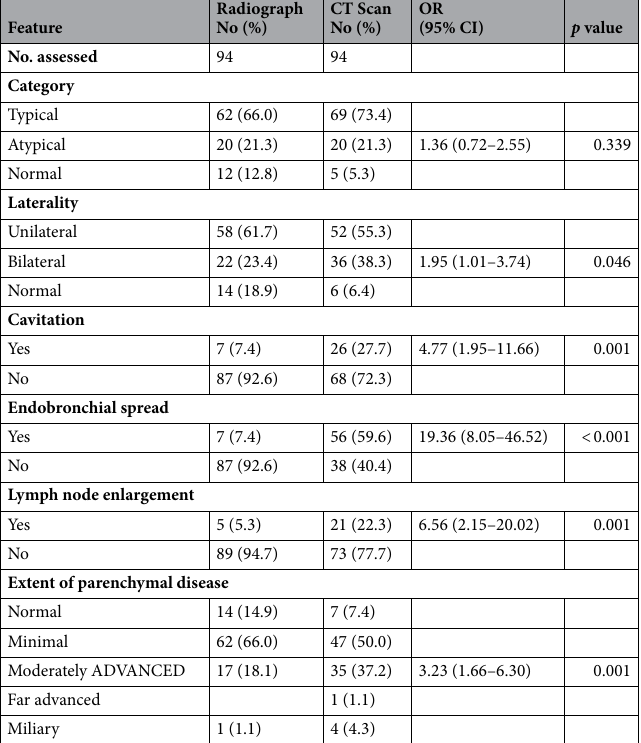
Table 4.. Detection of radiologic features among subclinical PTB patients by diagnostic imaging modality Abbreviations: PTB pulmonary tuberculosis; CT computed tomography; OR odds ratio; CI confidence interval. Adjusted for age and